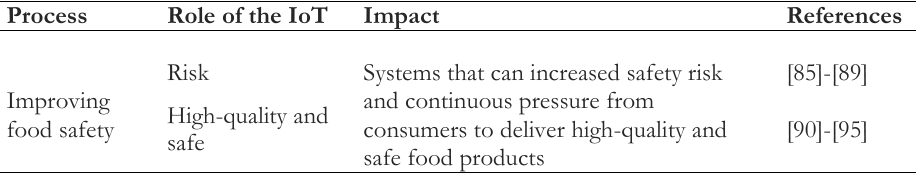
Table 7. Use of IoT in improving food safety in the food supply